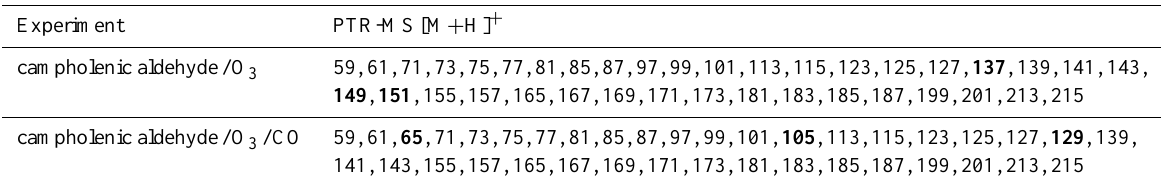
Table 2. Summary of detected gas-phase oxidation products from the performed campholenic aldehyde experiments using PTR-MS (differ- ences in detected products are shown in bold).